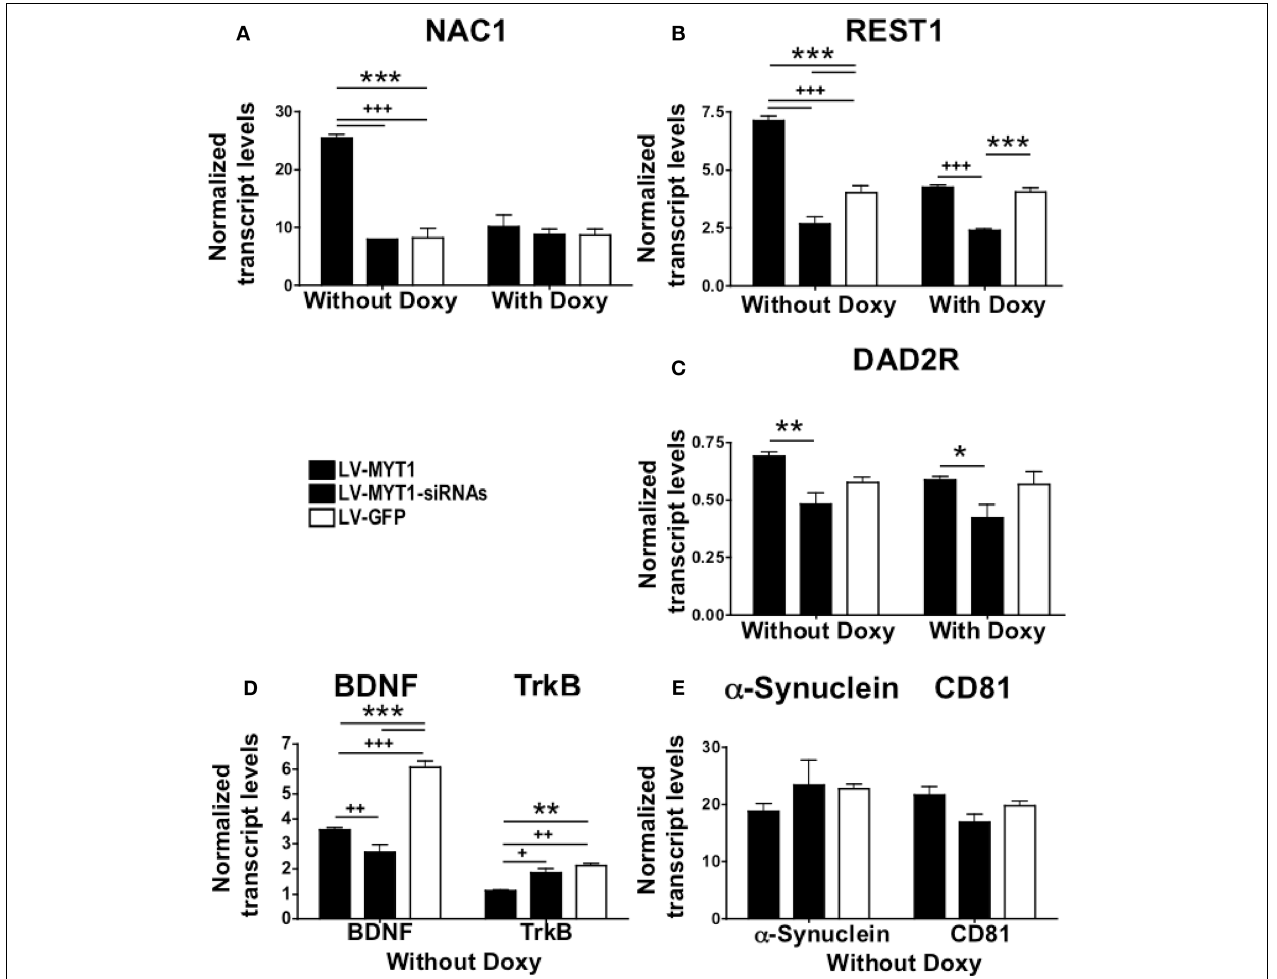
FIGURE 5 | NZF-2b/7ZFMyt1 in the NAc specifi cally alters expression of several reward-related genes. qRT-PCR quantifi cation of: NAC1 (A) ; REST1 (B) ; the dopamine receptor DAD2R (C) ; BDNF and its receptor TrkB (D) , α -Synuclein and the tetraspanin CD81 (E) . qRT-PCR was performed from NAc tissue of rats ( n = 7) bilaterally injected into the NAc with either LV-7ZFMyt1 or the LV-7ZFMyt1-siRNAs or LV-GFP (see Materials and Methods). Expression levels were calculated relative to cyclophilin. Ectopic expression of NZF-2b/7ZFMyt1 led to increased expression of NAC1 (A) REST1 (B) , DAD2R (C) and decreased